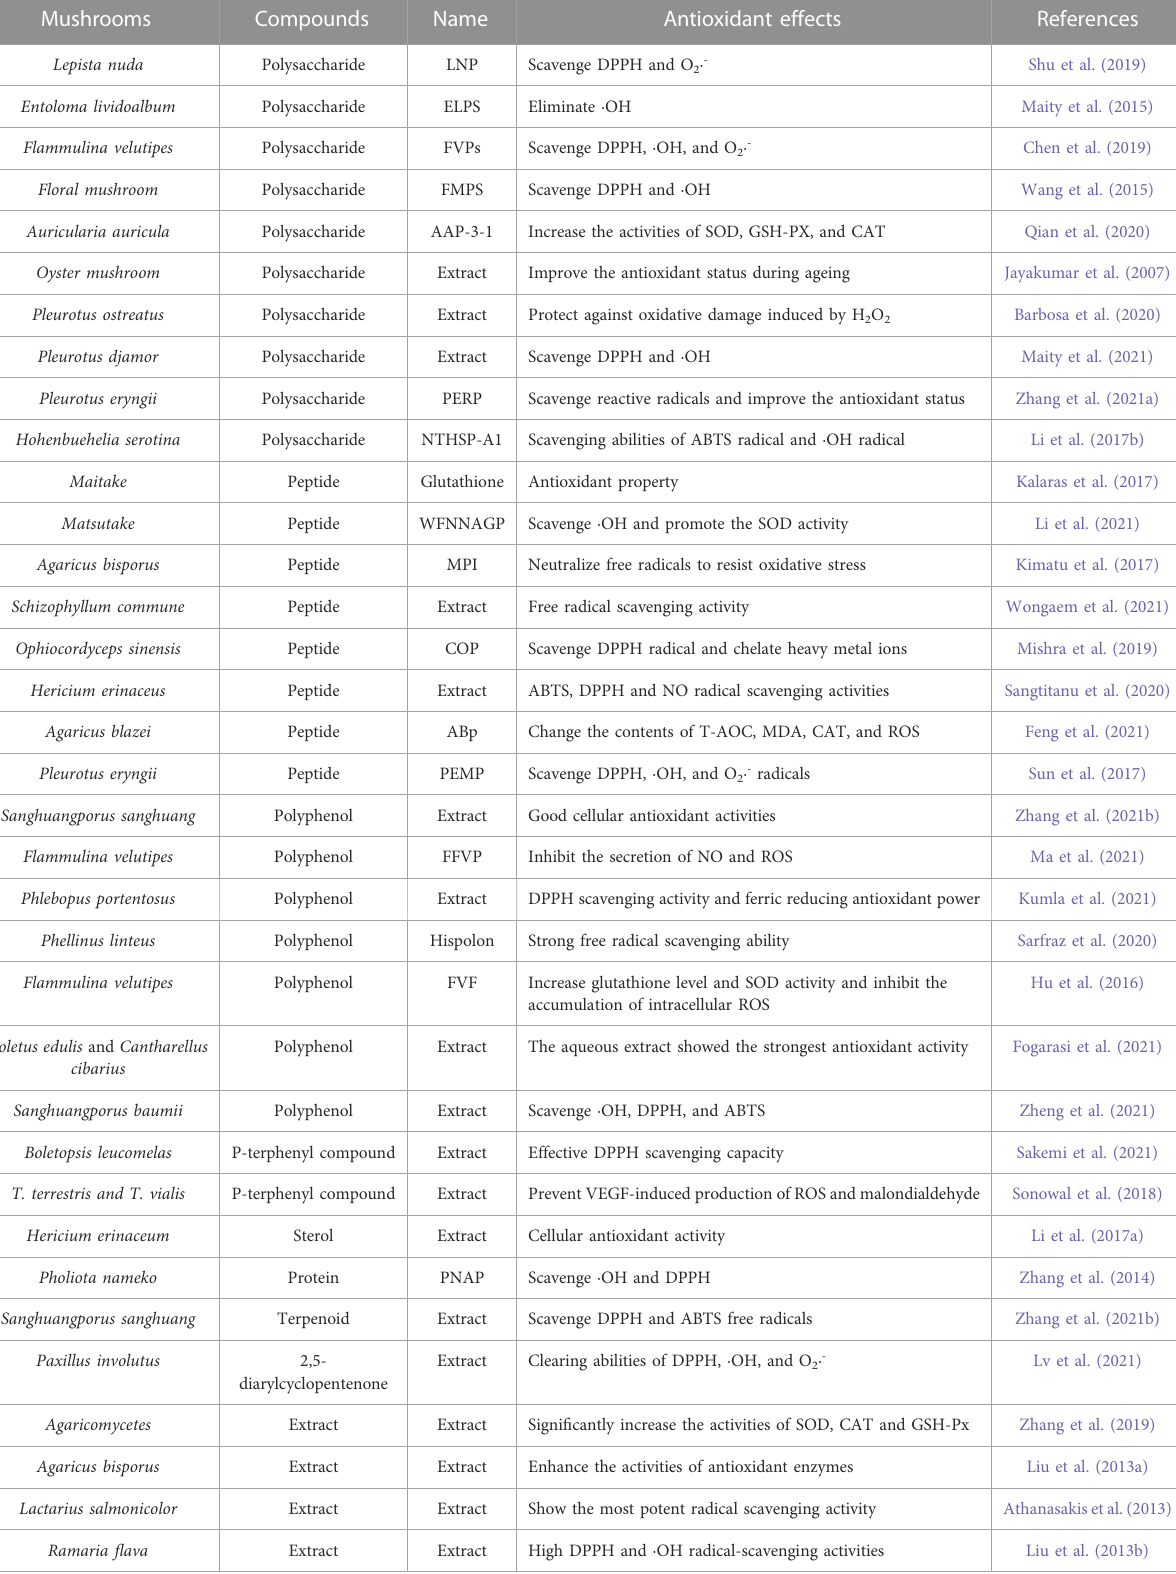
TABLE 1 Antioxidant effects of compounds puri fi ed from